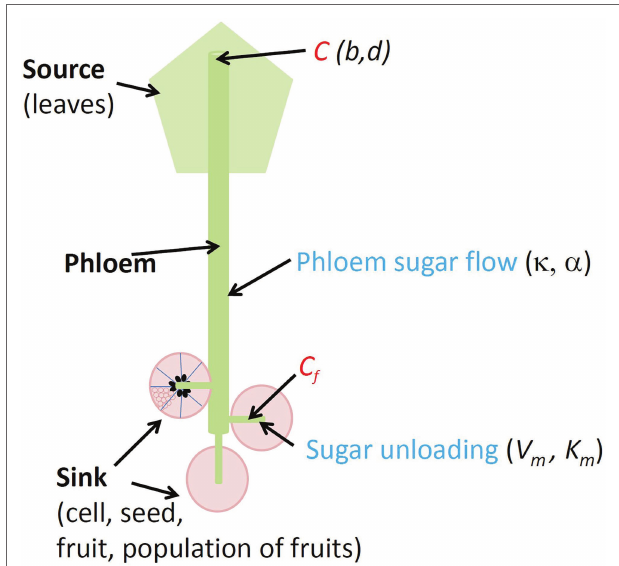
FIGURE 1 | Conceptual diagram of the density-dependence model (DDM). Objects (in bold black), sugar concentrations (in red) in plant phloem ( C ) and in sink phloem ( C f ), sugar transport (in blue) and corresponding model parameters (in italics) are